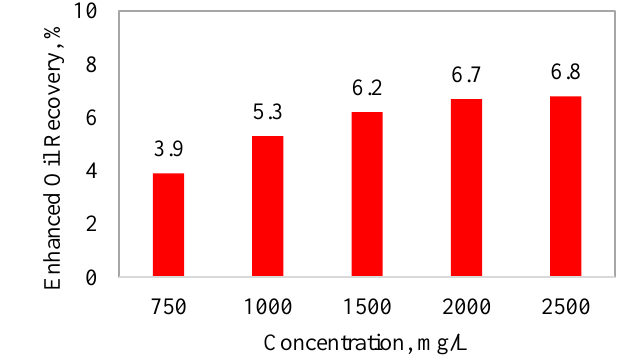
Figure 9—Numerical simulation of the effect of the size of the main slug on oil recovery.